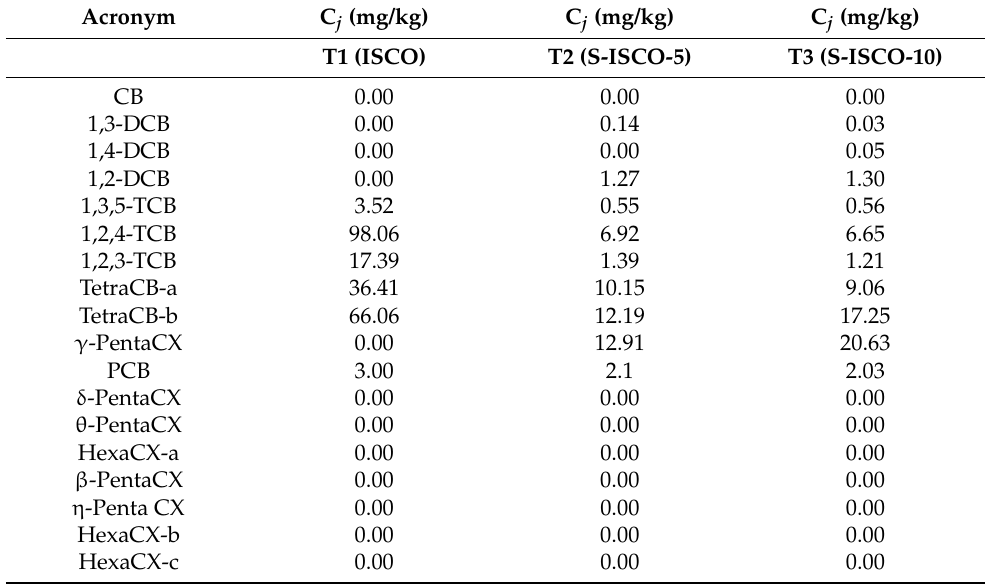
Table 3. COCs remaining in the soil columns after injection of 8 Pvs of reagents and 8 Pvs of tap